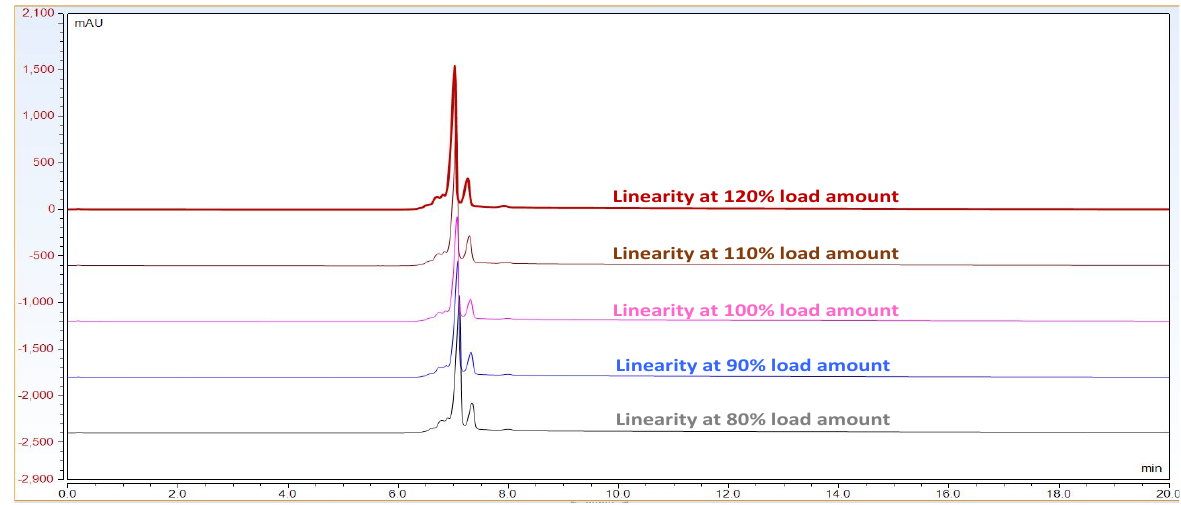
Figure 2. Representative CEX UPLC analysis data stacked overlay chromatogram for load linearity data from load ranging from 80 to 120%. This shows that the method is linear with good resolution in pre and post peaks from 80–120% of sample loading amount on column. X -axis represent time in mins. Additionally, Y -axis represents signal in mAU.